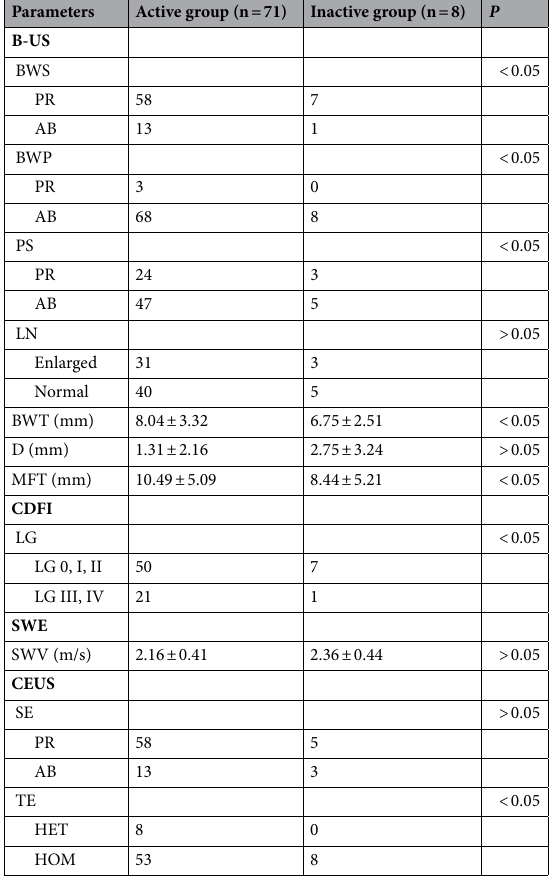
Table 3. Main US findings of four modes of CD lesions with different activity. (1) n is the number of the involved bowel segments; (2) divided into active group (CDAI ≥ 150) and inactive group (CDAI < 150); (3) nodes enlargements), LG (Limberg grade of the bowel wall vascularization), SWV (shear wave velocity), SE (presence of the stratified enhancement of the bowel), TE (existence of the homogeneous enhancement of the